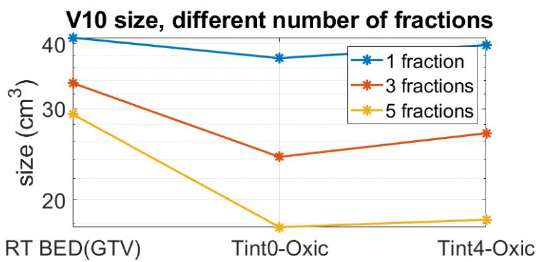
Figure 6. V 10 for compensated plans so that even with fractionation, we can still achieve BED equal to 37.5 Gy for 99.4% of the voxels in the